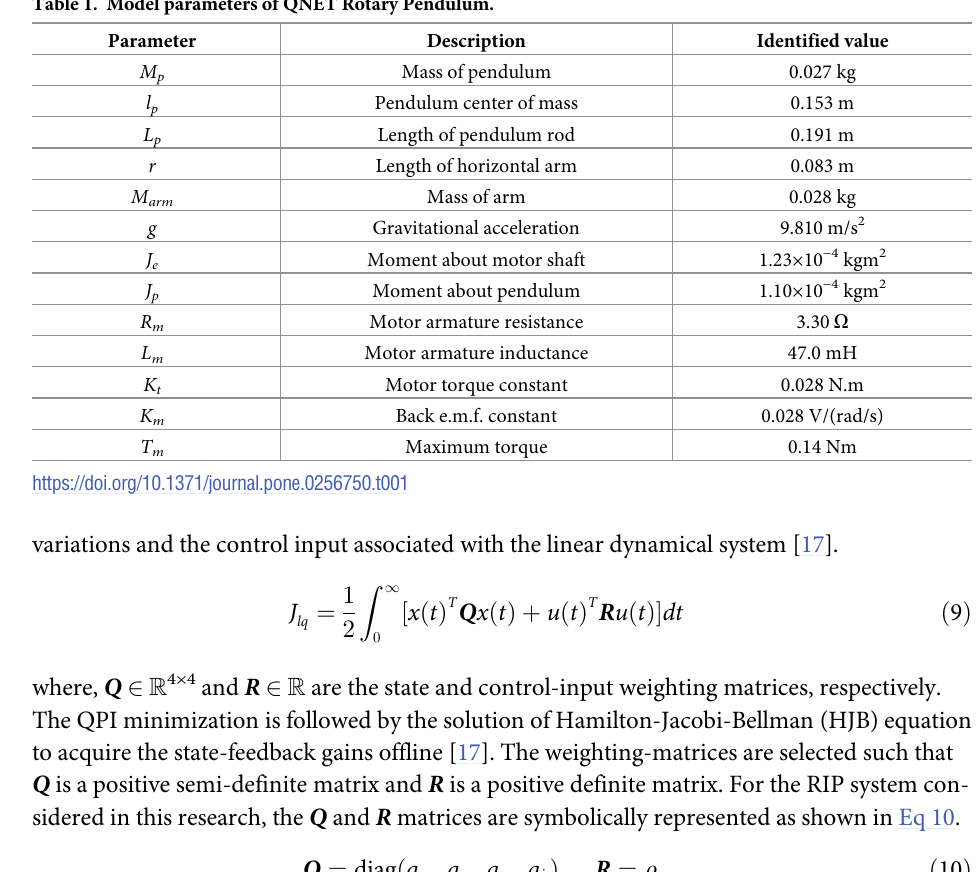
Table 1. Model parameters of QNET Rotary